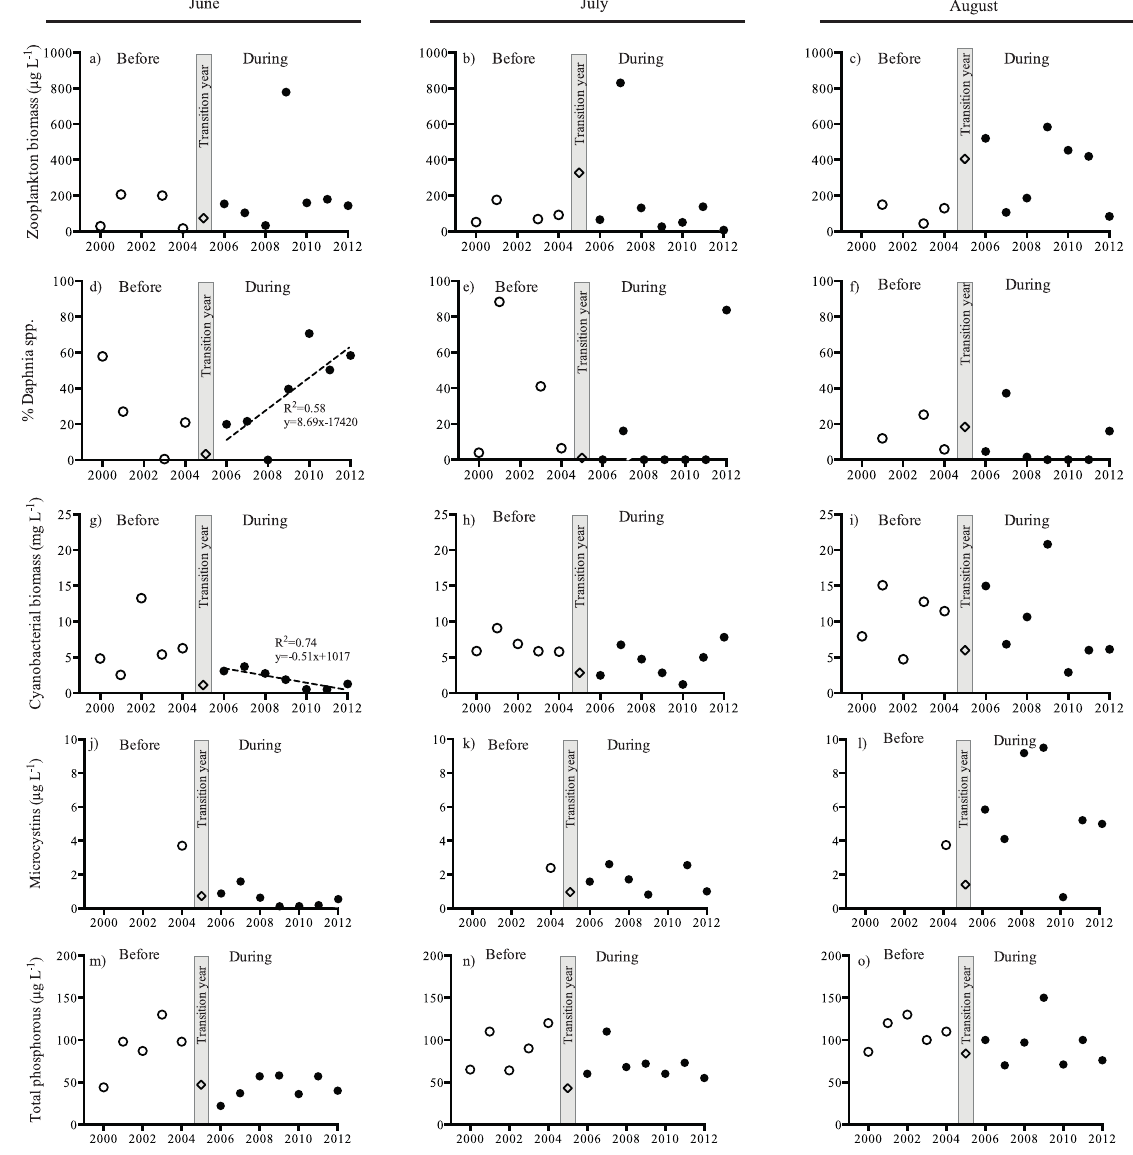
Figure 3. Lake data from Lake Ringsjo¨n (mean + SD) showing total zooplankton biomass (a–c), the proportion of Daphnia spp. (%) of total zooplankton biomass (d–f), cyanobacterial biomass (g–i), microcystin concentration (j–l) and total phosphorous concentration (m–o)